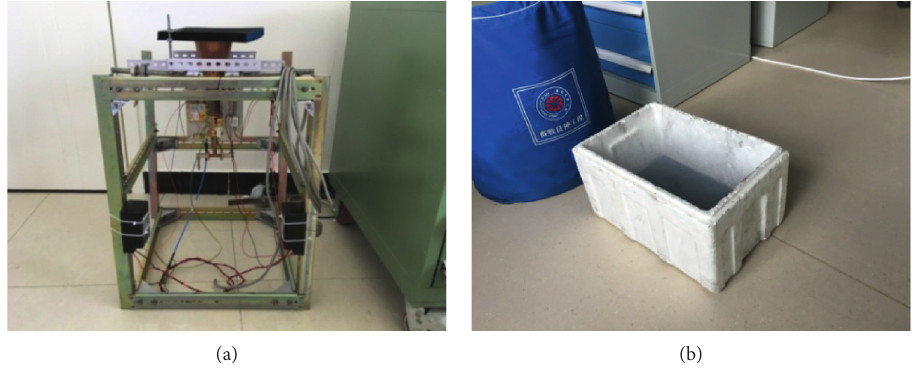
Figure 8: K-band test platform and cold load.